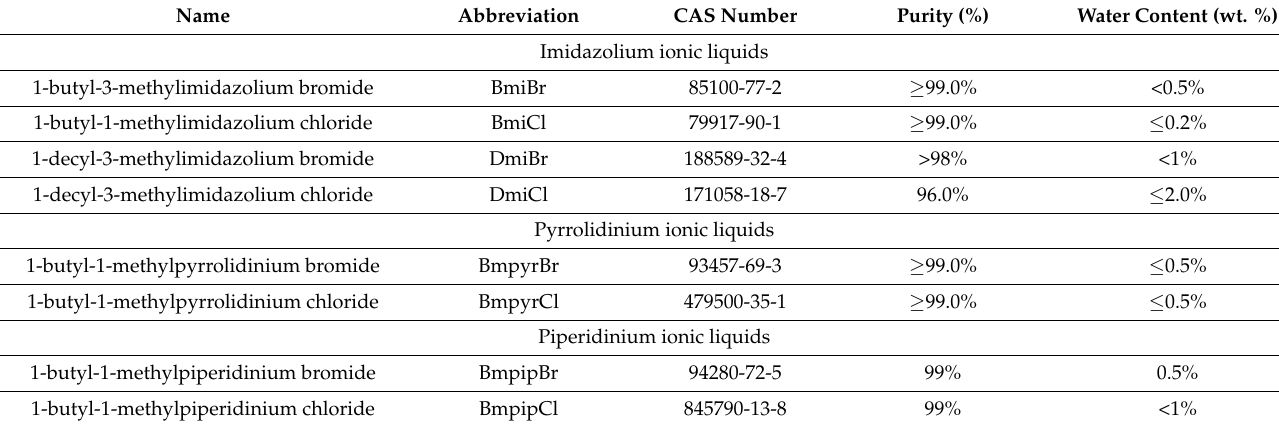
Table 1. Ionic liquids (ILs) used in the natural rubber (NR)